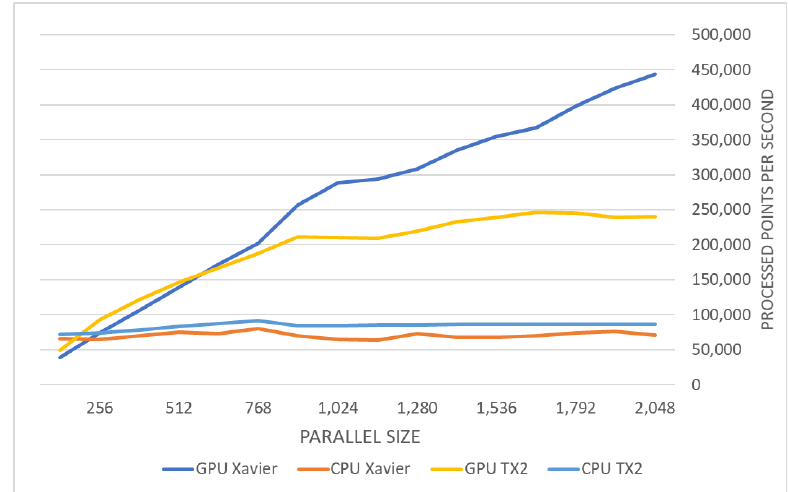
Figure 12. A complete comparison between: serial (CPU) EKF, parallel-serial (GPU) EKF, parallel (GPU) EKF execution for different batch sizes of up to 2048 in parallel